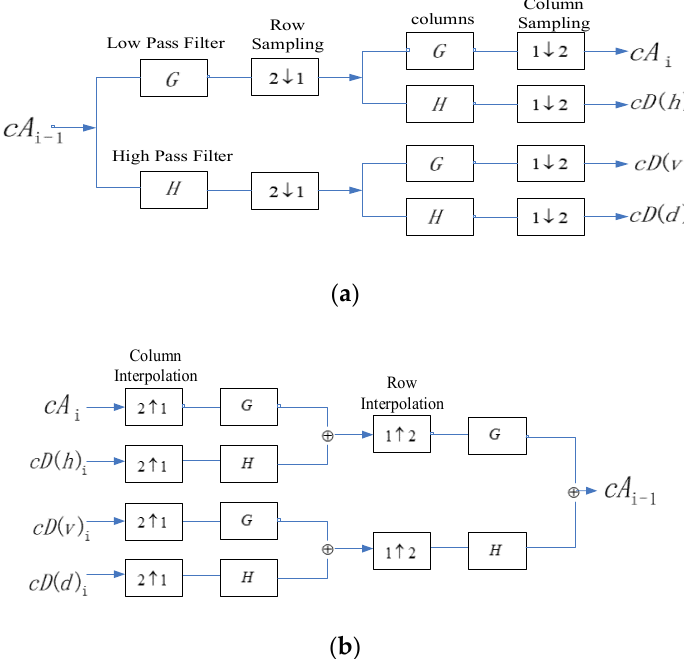
Figure 4. The DWT image decomposition and reconstruction processes: ( a ) the decomposition process; ( b ) the reconstruction process.